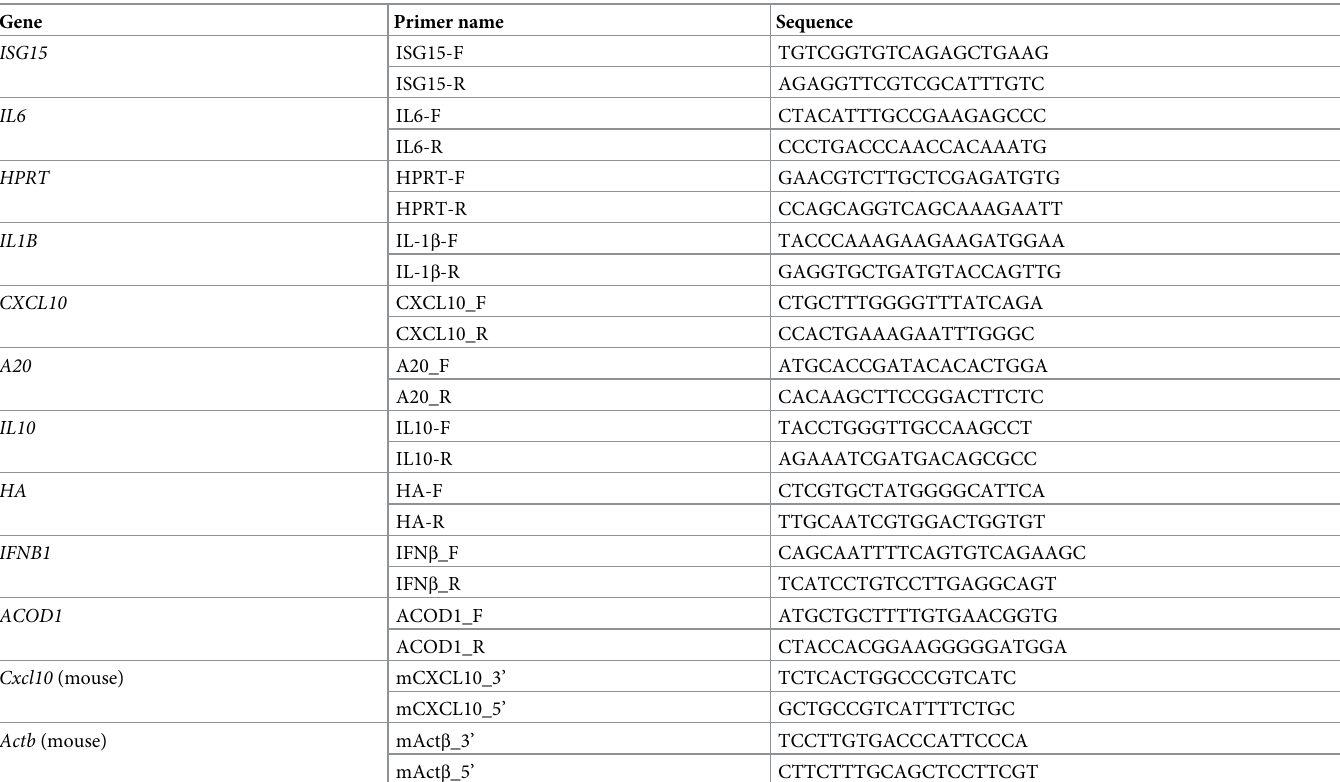
Table 3. List of RT-qPCR primers.